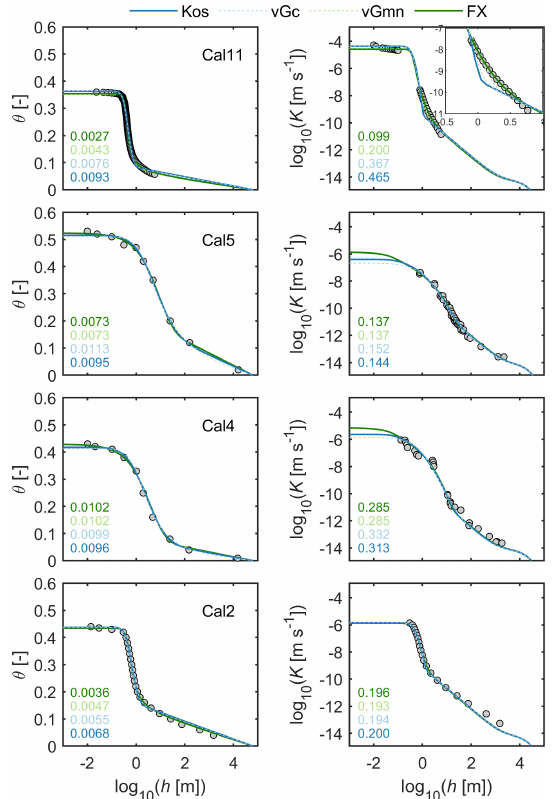
Figure 2. Plots of 4 of the 12 calibration data sets and the fitted water retention and conductivity functions used to calibrate the sat- urated tortuosity coefficient τ s in Eq. (19). Parameter λ was set to a value of 0.5 according to Mualem (1976a). Parameter τ s and the retention parameters were allowed to vary. Numbers in the subplots indicate RMSE θ and RMSE log K values for the various model com-